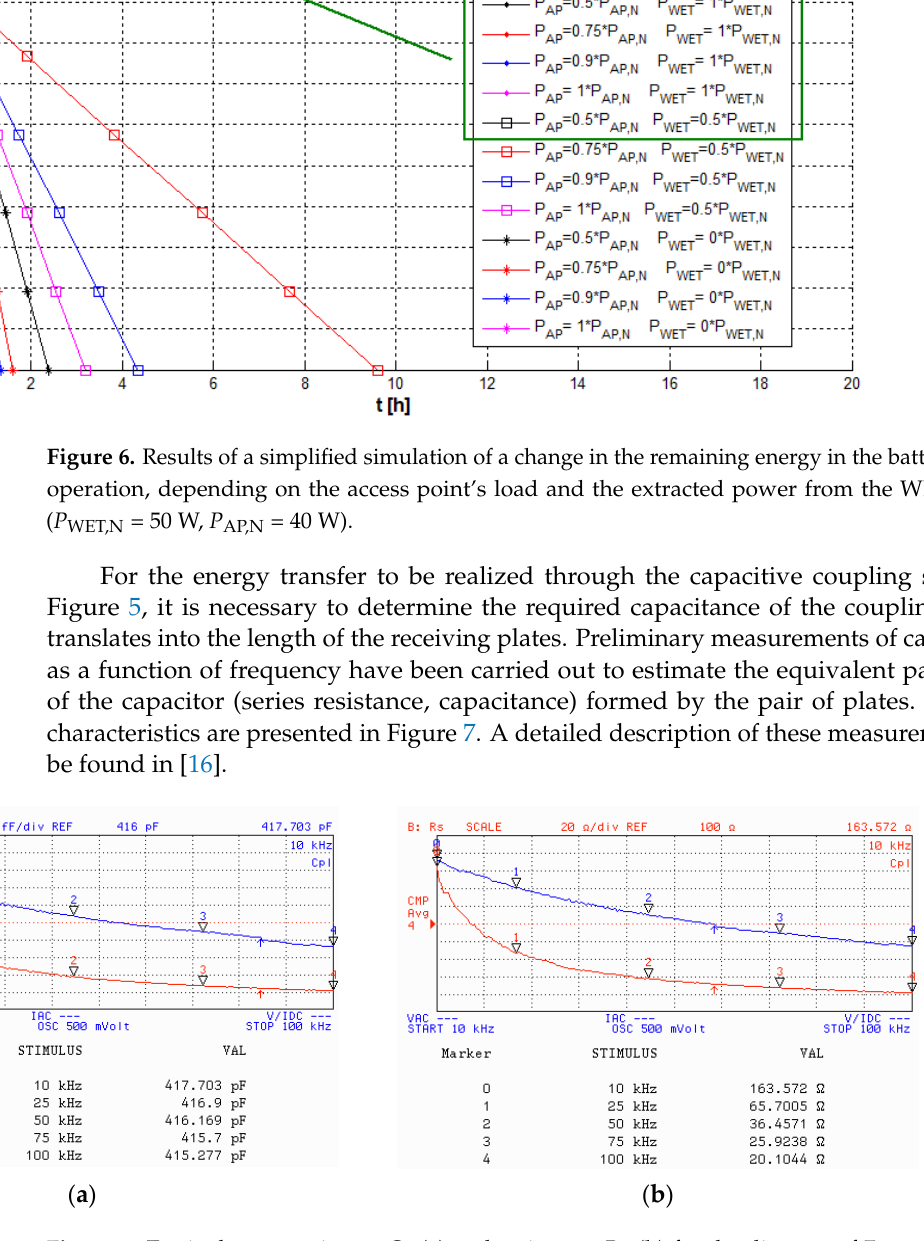
Figure 7. Equivalent capacitance C S ( a ) and resistance R S ( b ) for the distance of 7 mm (dielectric layer) as a function of the frequency [16].